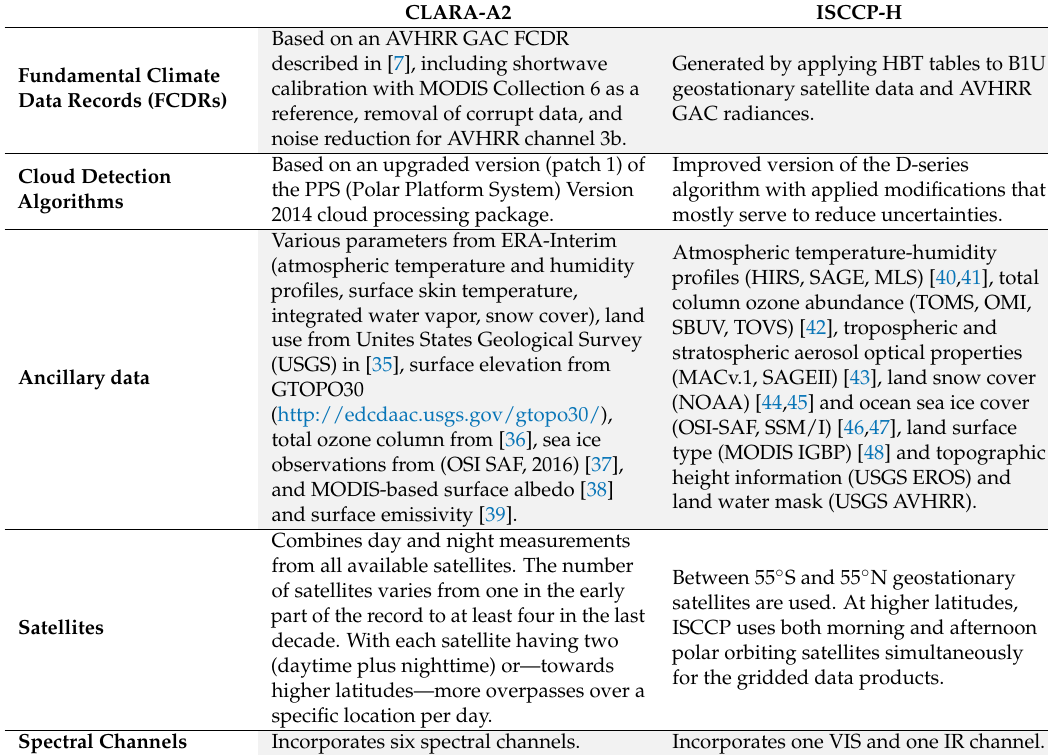
Table 1. Summary of main differences between the CLARA-A2 and ISCCP-H cloud data records.